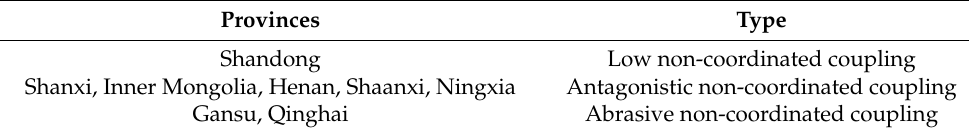
Table 6. Spatial clustering results.